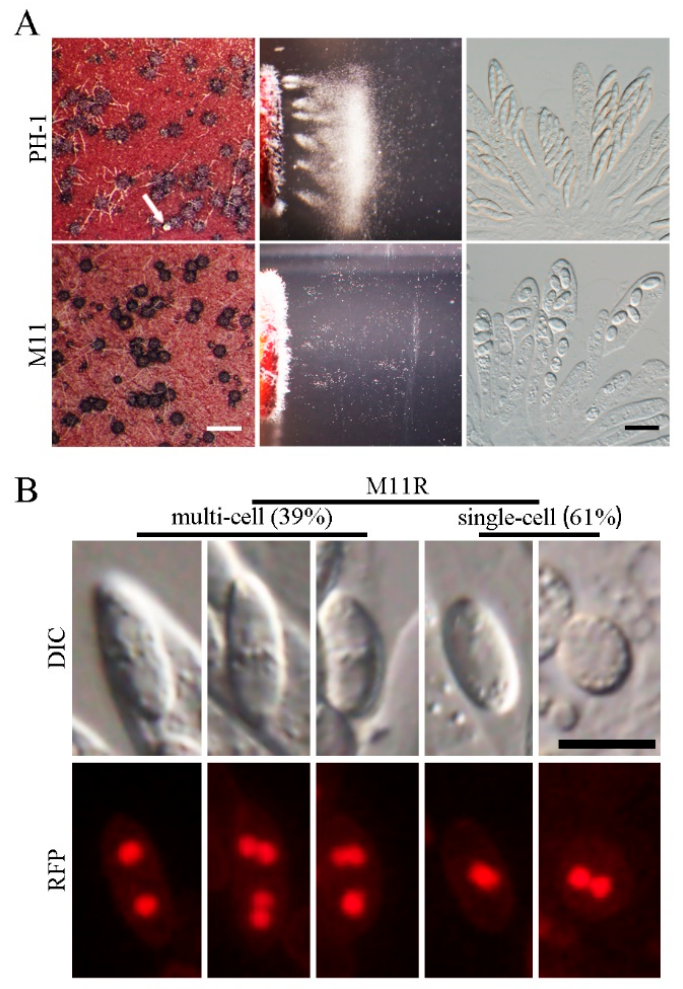
Figure 3. Assays for the defects of the Fgcsn12 mutant in sexual reproduction. ( A ) Mating cultures of the wild type (PH-1) and Fgcsn12 mutant (M11) were examined for perithecium formation (left), ascospore discharge (middle), and asci with ascospores (right) 8 days postfertilization (dpf). Ascospore cirrhi are indicated by white arrows. White bar = 1 mm; black bar = 20 µ m. ( B ) Ascospores of M11 expressing H1-RFP (M11R) were examined by differential interference contrast (DIC) or epifluorescence microscopy (RFP). The number of cells was randomly calculated from 600 ascospores. Bar = 10 μ m.